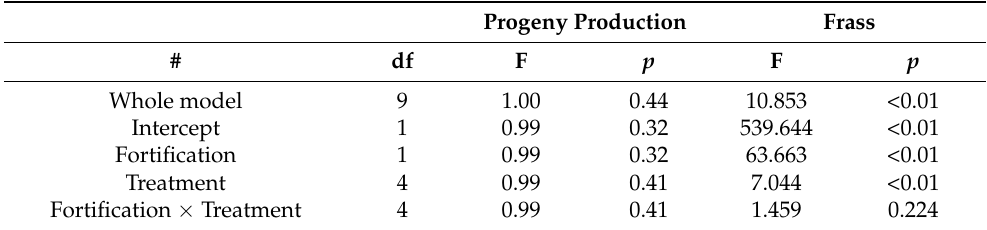
Table 3. ANOVA parameters for population growth of Oryzaephilus surinamensis and quality parame- ters (frass, number of damaged kernels (NDK) and weight of damaged kernels (WDK)) in vials that contained rice fortified with spearmint or basil at 0, 25, 50, 75 and 100% (total df = 70).